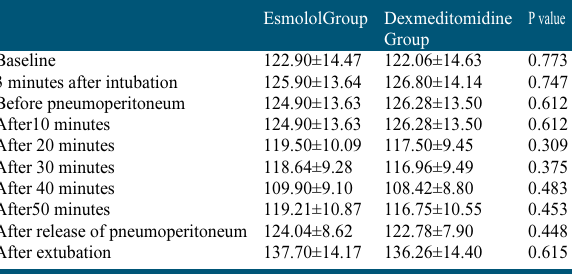
Table 4: Systolic blood pressure (SBP)